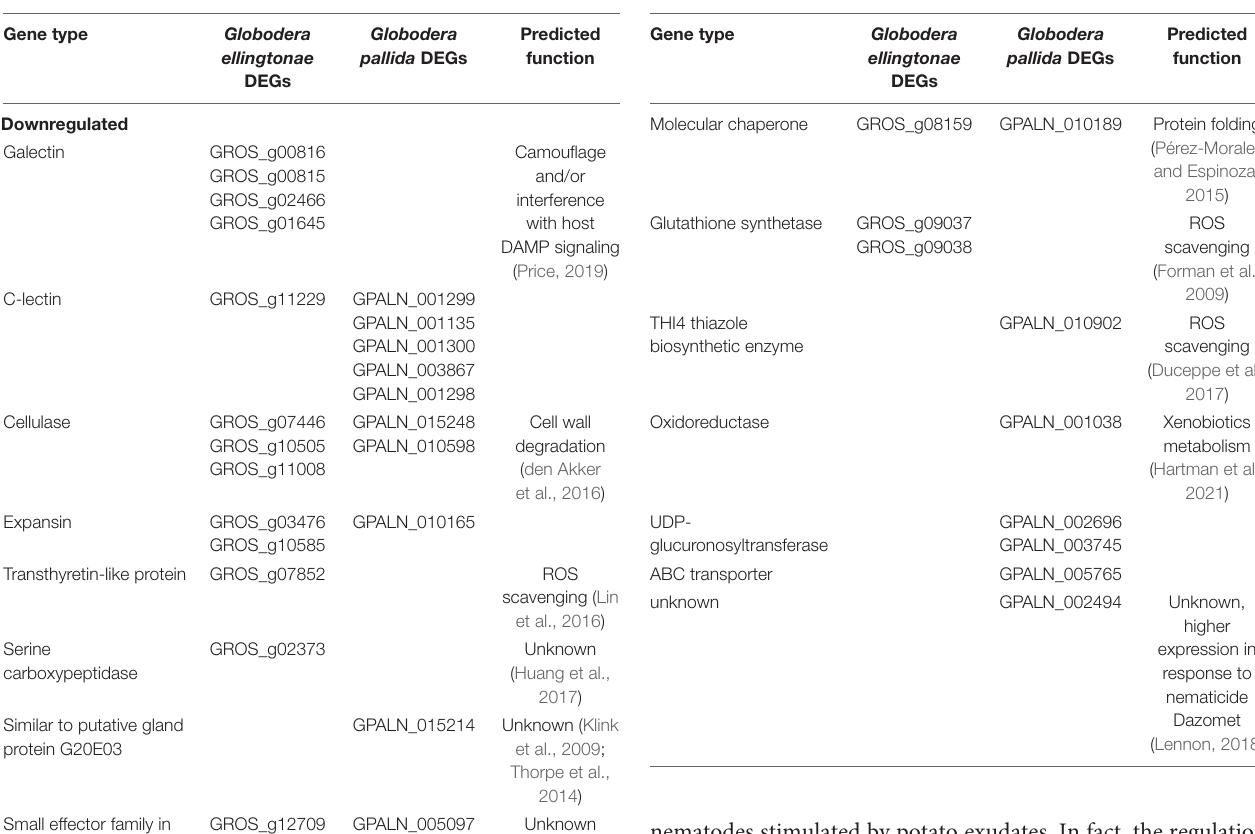
TABLE 3 | Differentially regulated genes in SSI hatching treatment compared with potato hatching treatments (resistant - INN or susceptible - DS), predicted to have function in detoxification